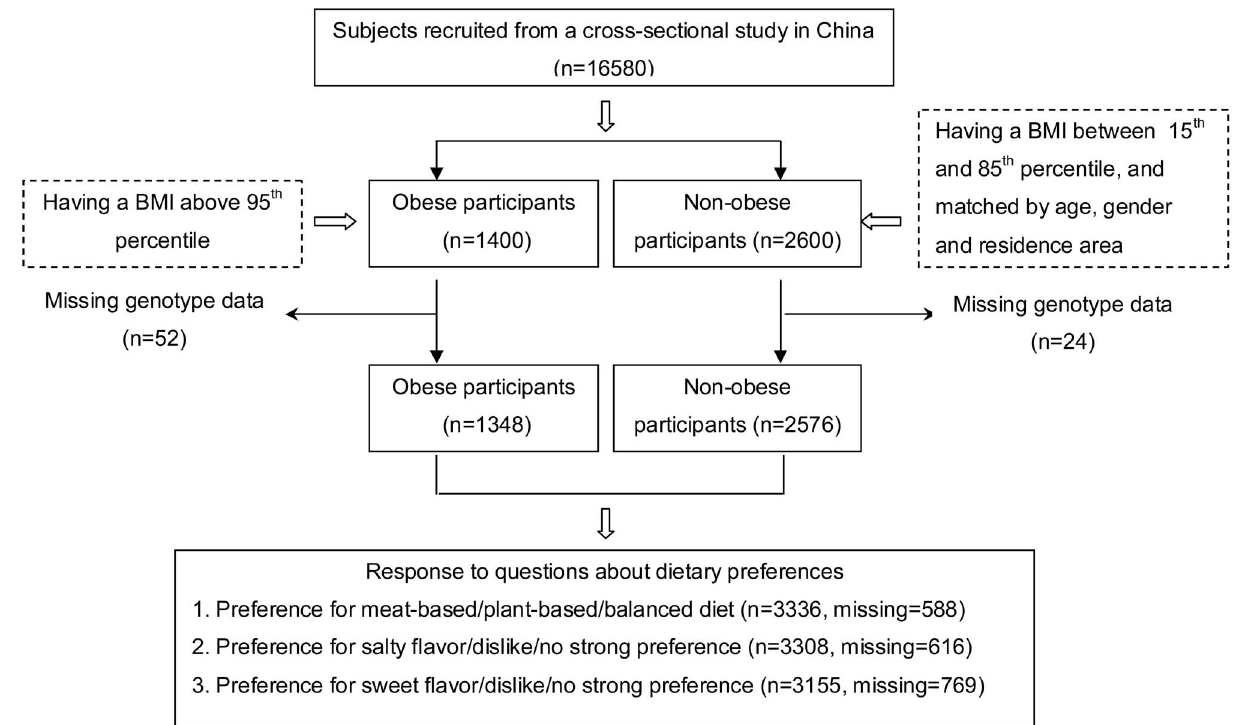
Figure 1. Participant selection and disposition.